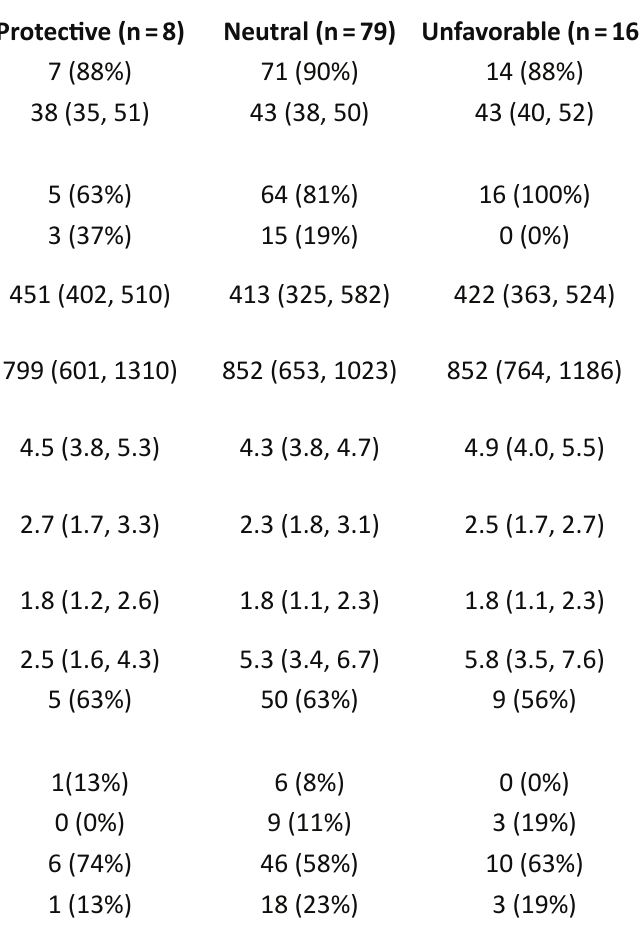
Supplementary Table 3. Baseline characteristics for HLA-C groups